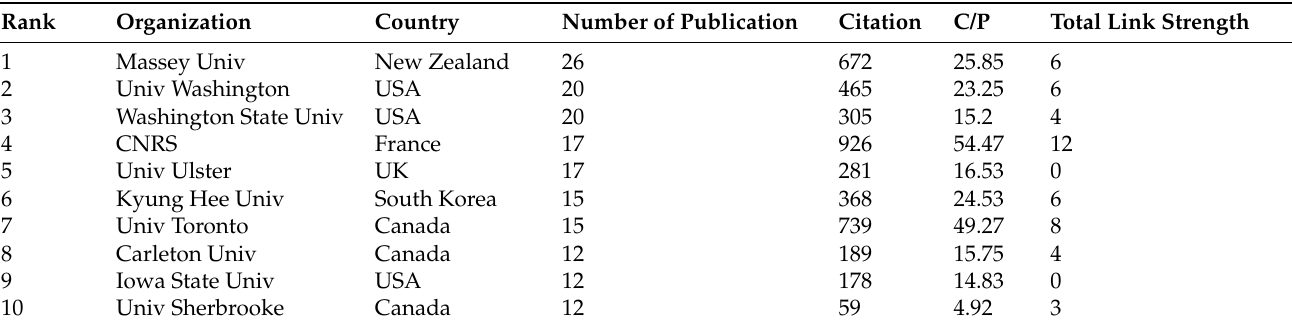
Table 5. Top 10 most productive